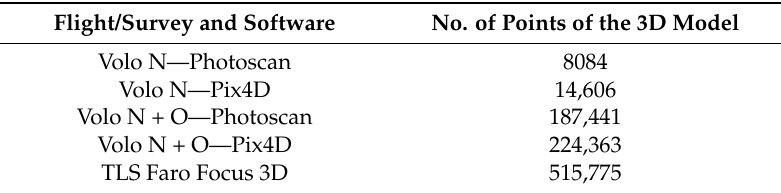
Table 12. Number of points in the north façade.